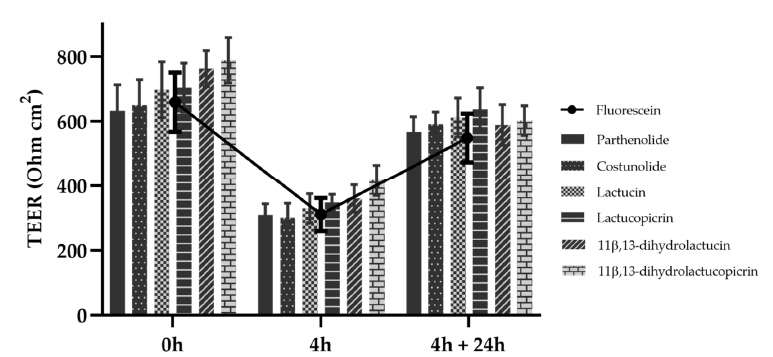
Figure 3. Transepithelial electrical resistance (TEER) of Caco-2 cells. TEER measurements were made before and after the 4 h permeability experiment and at the 24 h recovery period after the end of the assay. SLs were tested at a concentration of 10 µ M and fluorescein at 2.7 µ M. Data are presented as means ± SD, n = 3. Samples were collected from the apical side at the beginning of the experiment and after 4 h, and Table 3. Concentration of SLs in the apical compartment before and after the permeability experiment. Compound